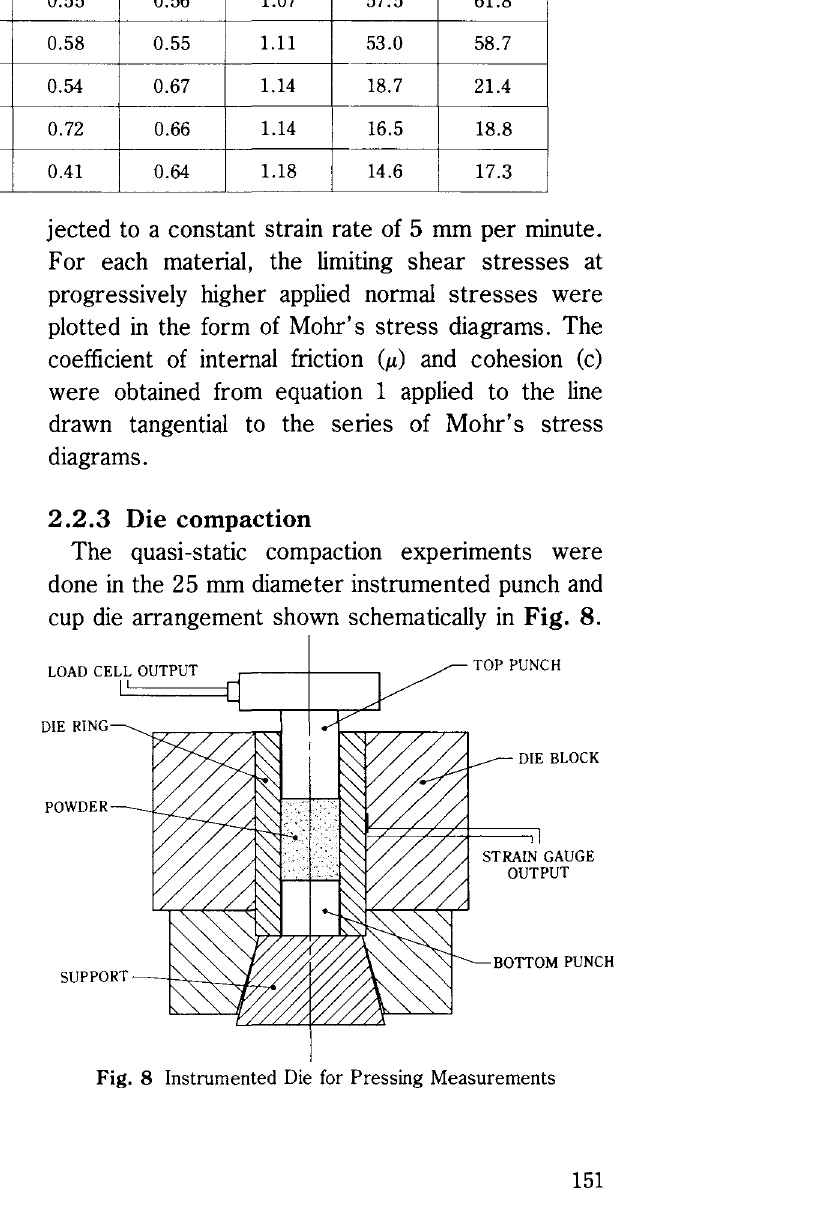
Fig. 8 Instrumented Die for Pressing